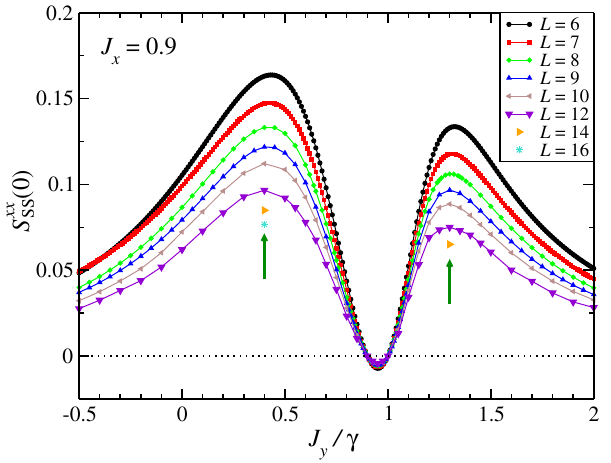
FIG. 5. Ferromagnetic spin-structure factor along the x direc- tion, in a 1D setup, as a function of J y . The various curves and symbols stand for different system sizes from L ¼ 6 to L ¼ 16 , as indicated in the plot. The two arrows point at the positions of the two peaks ( J y ¼ 0 . 4 and J y ¼ 1 . 3 ), for which we provide a finite-size scaling (Fig. 6) and an analysis of the two-point correlation functions (Fig. 7). Here, we have set J x ¼ 0 . 9 and J 1 , and we work in units of γ . Note that for J z ¼ J 1 , the spin structure factor is rigorously y ¼